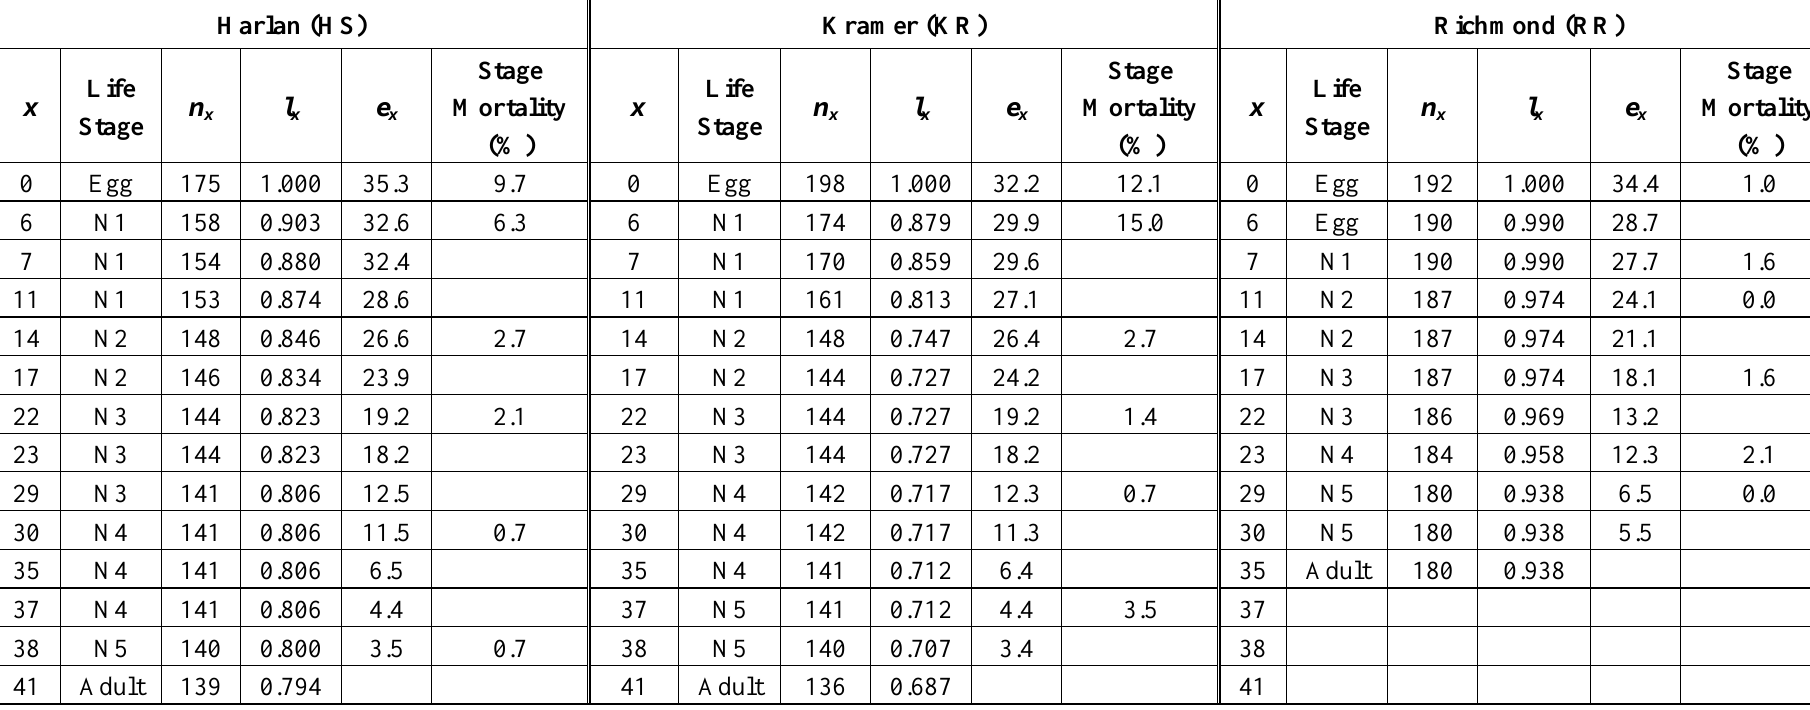
Table 2. Abridged survivorship life tables for the immature stages of Harlan (HS), Kramer (KR), and Richmond (RR) strains of the common bed bug, Cimex lectularius *